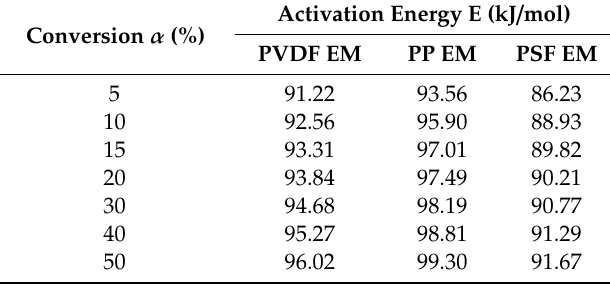
Figure 10. TGA curve of three encapsulation membranes and a linear correlation diagram of Ozawa; ( a ) is PVDF EM; ( b ) is PP EM; ( c ) is PSF EM; ( a ), ( b ), ( c ) are TGA curves with different heating rates; ( a 1 ), ( b 1 ), ( c 1 ) are linear correlation diagrams. Table 5. Activation energies of samples according to Flynn-Wall-Ozawa’s method.